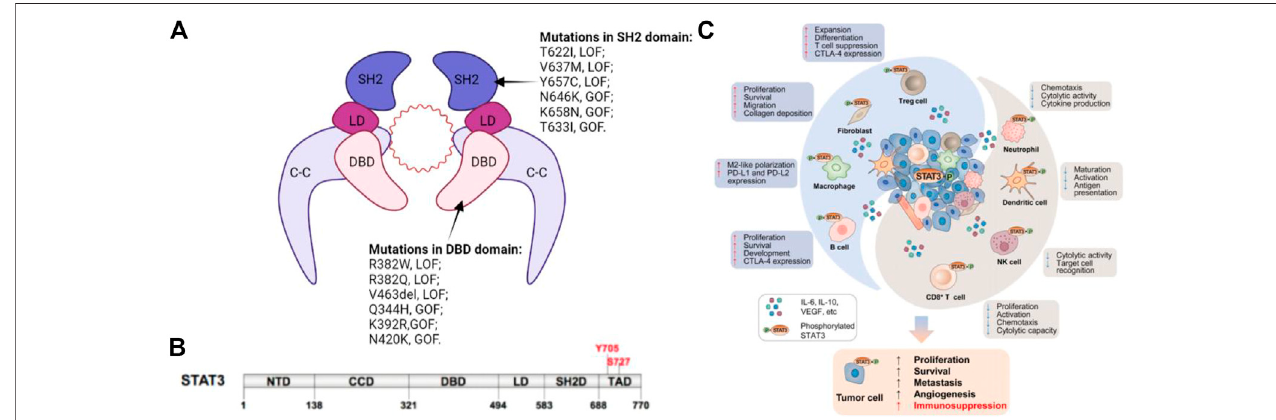
FIGURE 1 | (A) Schematic illustration of STAT3 dimer bound to DNA. This is a representation of the major STAT3-DNA binding complex (resolved in the X-ray crystalstructure). (B) Primarystructure ofSTAT3showingdomainorganizationalongthepolypeptidechain. (C) STAT3 inducesimmunosuppressionintheTME.STAT3 activities in tumor cells augment cancer hallmarks, including increased secretion of immunosuppressive factors, such as IL-6, IL-10, and EGFR, which can activate STAT3 in innate and adaptive immune cell subsets as well as CAFs in the TME. Immune cells and CAFs within the TME can release certain factors, including IL-6, which enhances STAT3 signaling in tumor cells. Elevated STAT3 in the TME has dual effects.